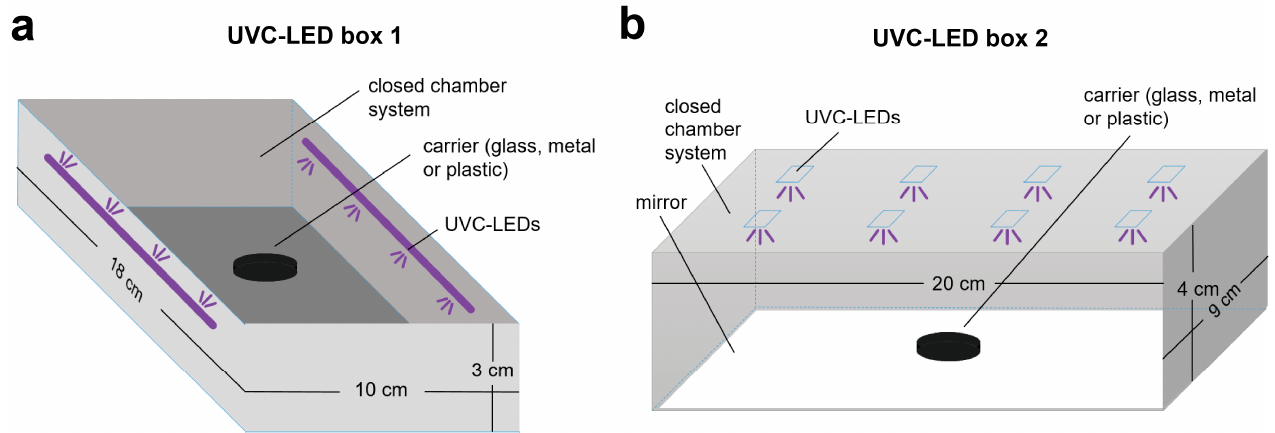
Figure 1. Schematic illustrations of the UVC-LED boxes used for UVC-disinfection. ( a ) UVC-LED box 1 (Horcol) was equipped with lateral UVC-LEDs. ( b ) UV-LED box 2 (expondo GmbH, Berlin, Germany) was equipped with UVC-LEDs incorporated in the lid and a mirror installed at the bottom of the chamber.